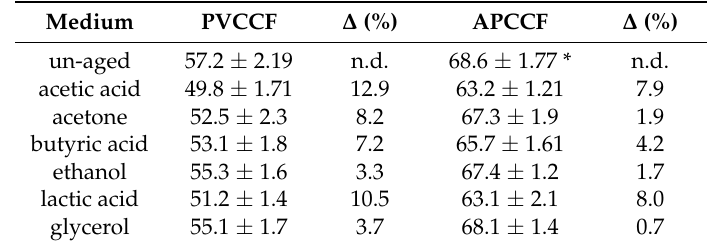
Table 1. Comparison between the tensile strength properties of PVC-coated polyester fabric (PVCCF) and all-polyamide composite-coated-fabric (APCCF). Un-aged samples are the ones before ageing.